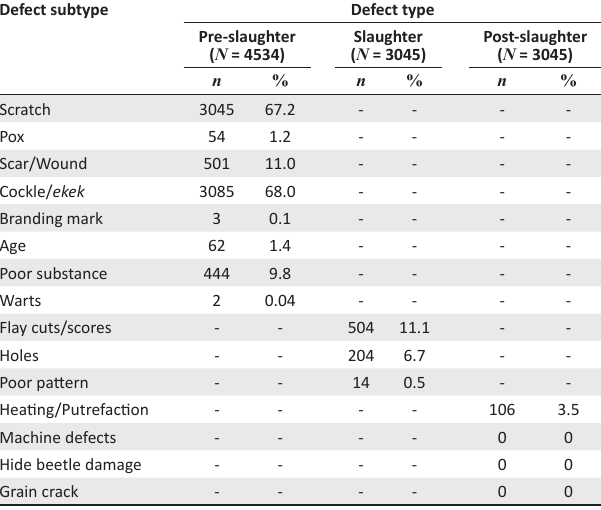
TABLE 1: Pre-slaughter, slaughter and post-slaughter defects observed in pickled sheep skins from the Tigray region, Ethiopia. Defect subtype